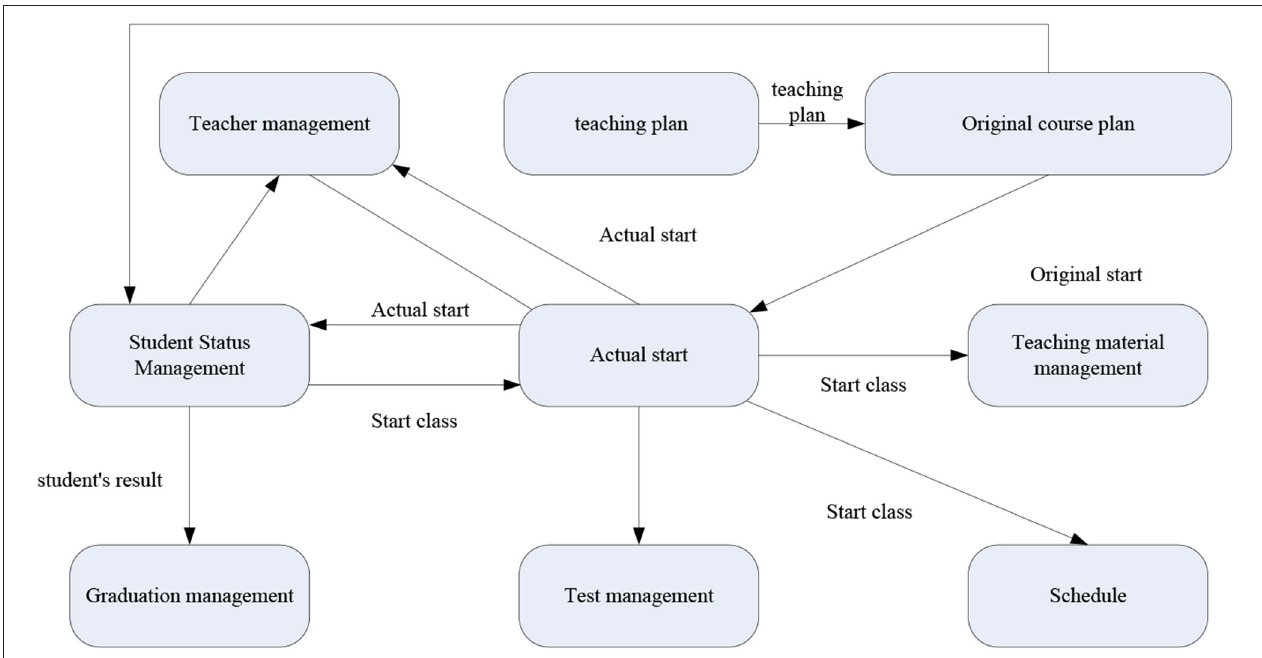
FIGURE 3 | The data flow between the modules